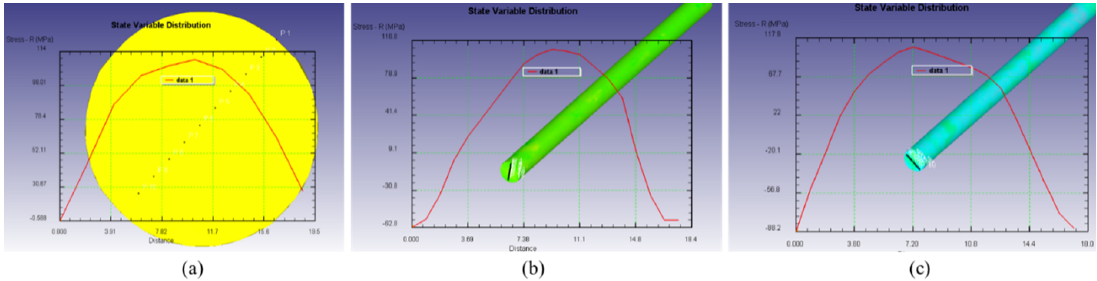
Figure 10. The residual stresses in the radial direction with different die geometries and die movement velocities ( a ) at 0.7 m/min, ( b ) at 1.25 m/min and ( c ) at 2 m/min feed rate.